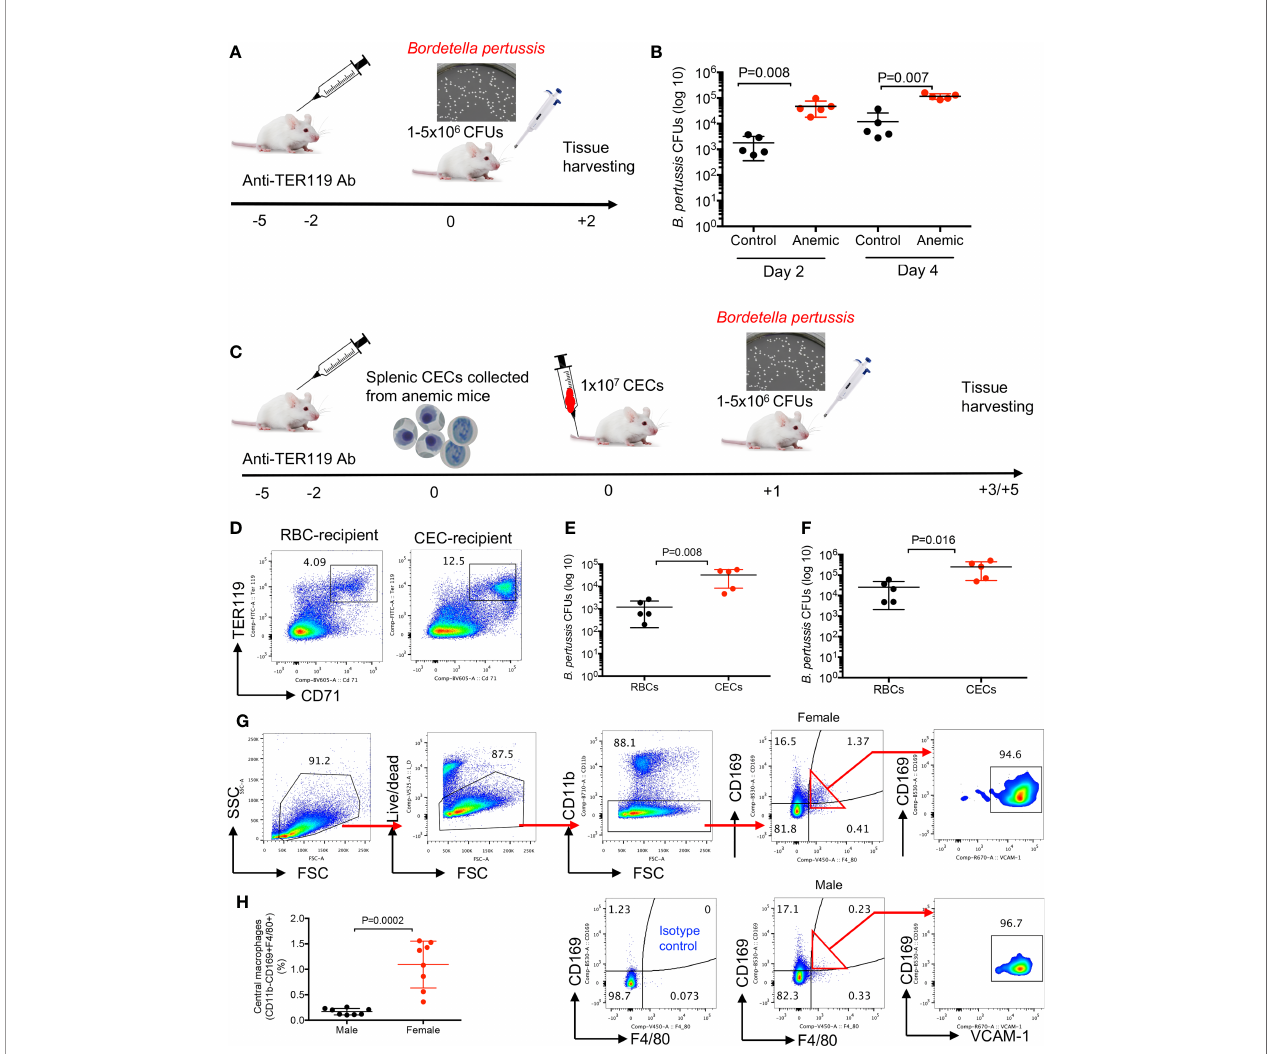
FIGURE 4 | Anemia and anemic-induced CECs enhance susceptibility to infection in female mice. (A) A schematic representation of the anti-TER119 antibody treatment and intranasal infection of mice with B. pertussis bacteria. (B) Cumulative data of number of isolated B. pertussis shown as colony forming units (CFUs) from the lung homogenates of control (IgG2b-treated) and anemic (anti-TER119-treated) mice 2 and 4 days ’ post-infection. (C) A schematic representation of the anti-TER119 antibody treatment, isolation of splenic CECs, tail vein injection of CECs and intranasal infection of mice with B. pertussis . (D) Representative fl ow cytometry plots of percentages of CECs in the spleen of control versus CEC-treated female mouse. (E) Cumulative data of number of isolated B. pertussis from the lung homogenates of control (RBC-injected) and CEC-injected mice 2, and (F) 4 days ’ post-infection. (G) Representative fl ow cytometry plots, and (H) cumulative data of central macrophages in female versus male mice. Each point represents data from an individual mouse, representative of at least two independent experiments. Bar, mean ± standard